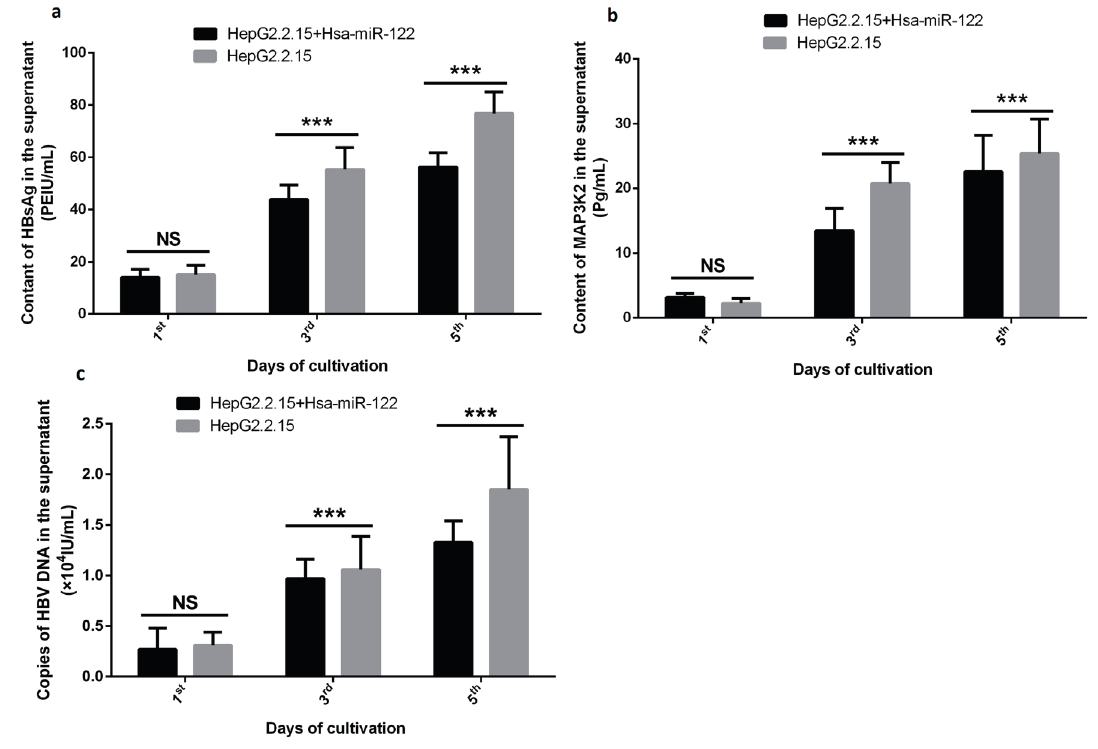
Figure 4 - The number of HBV-DNA copies a , levels of HbsAg b , and levels of MAP3K2 c in the cell culture from different groups at different time points (24 h, 72 h and 120 h) are shown in Figure 4 and Table Ⅱ. The number of HBV- DNA copies and the levels of HbsAg and MAP3K2 gradually increased in an equal volume of cell supernatant in a time- dependent manner. However, the rate of increase of the three indicators in the observer group was significantly inhibited, compared with in the control group.